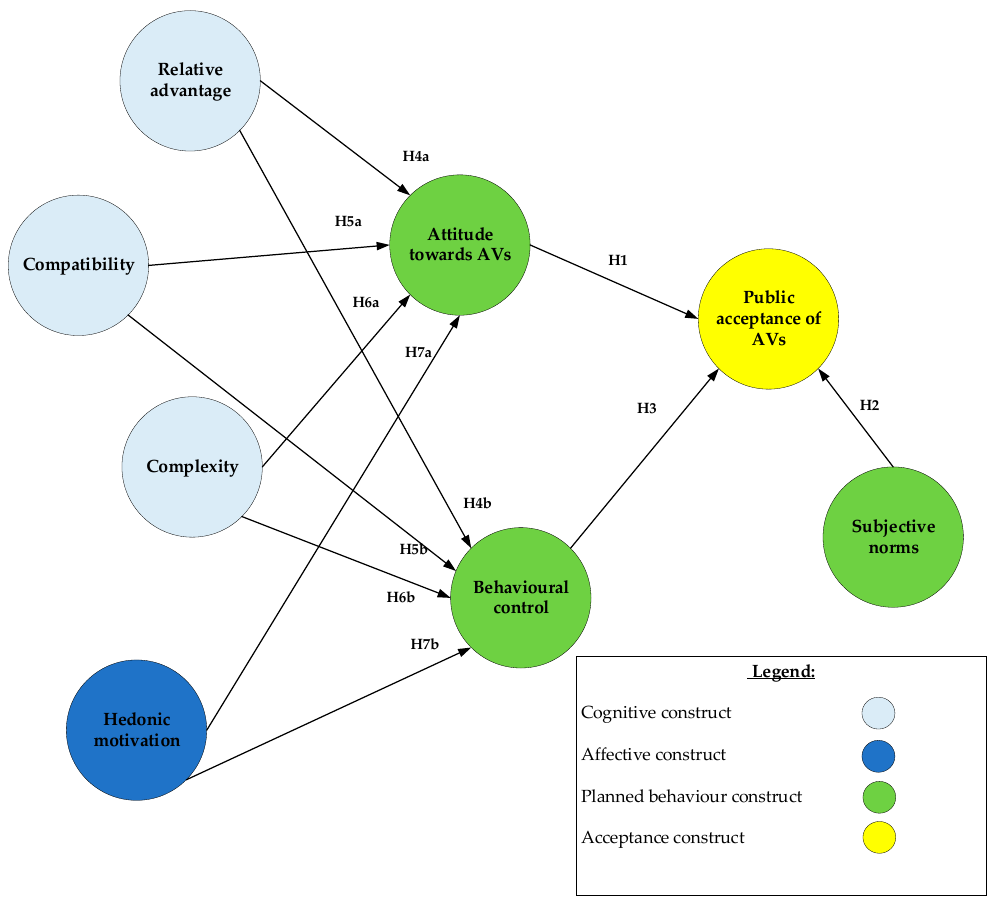
Figure 1. The theoretical model.